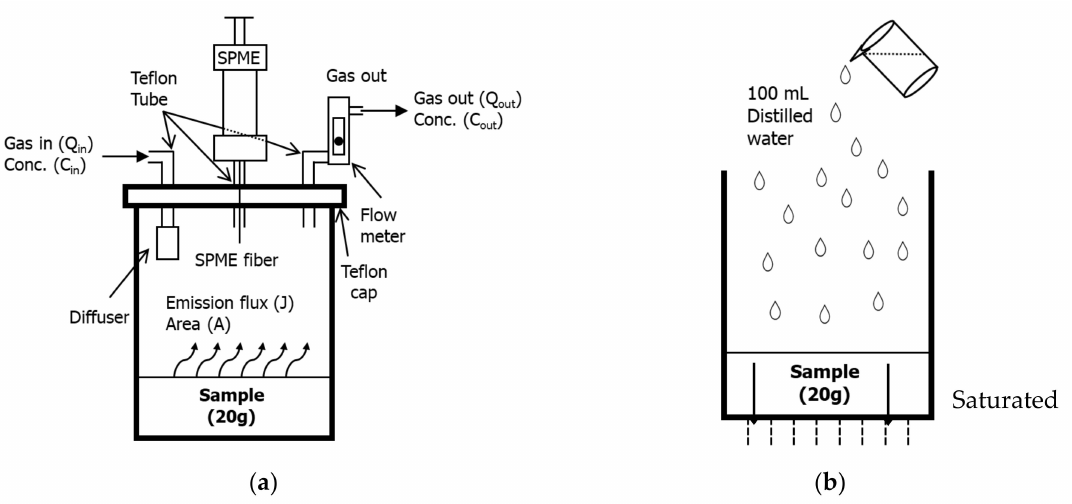
Figure 1. Schematic diagram of the set of the experiments: ( a ) reactor for VFAs, TRS, VOCs, and N 2 O analysis; ( b ) reactor for heavy metals in the